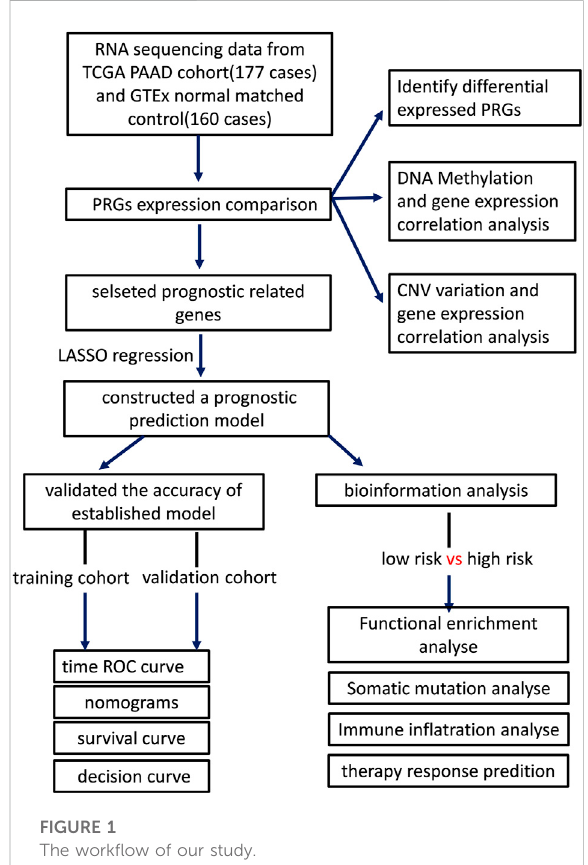
FIGURE 1 The work fl ow of our